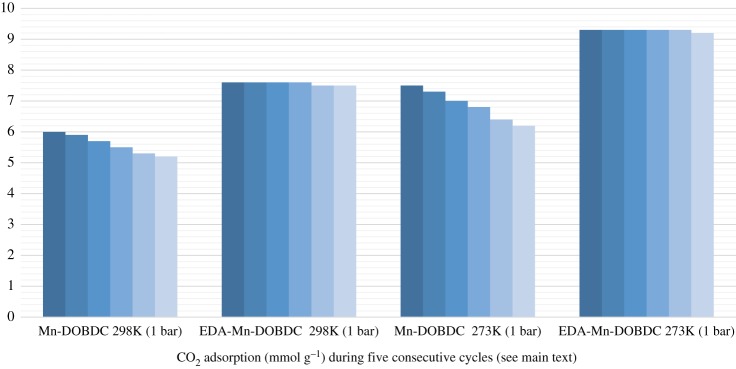
CO2 adsorption at 1 bar in mmol g−1 for Mn-DOBDC and EDA-Mn-DOBDC at 273 and 298 K.